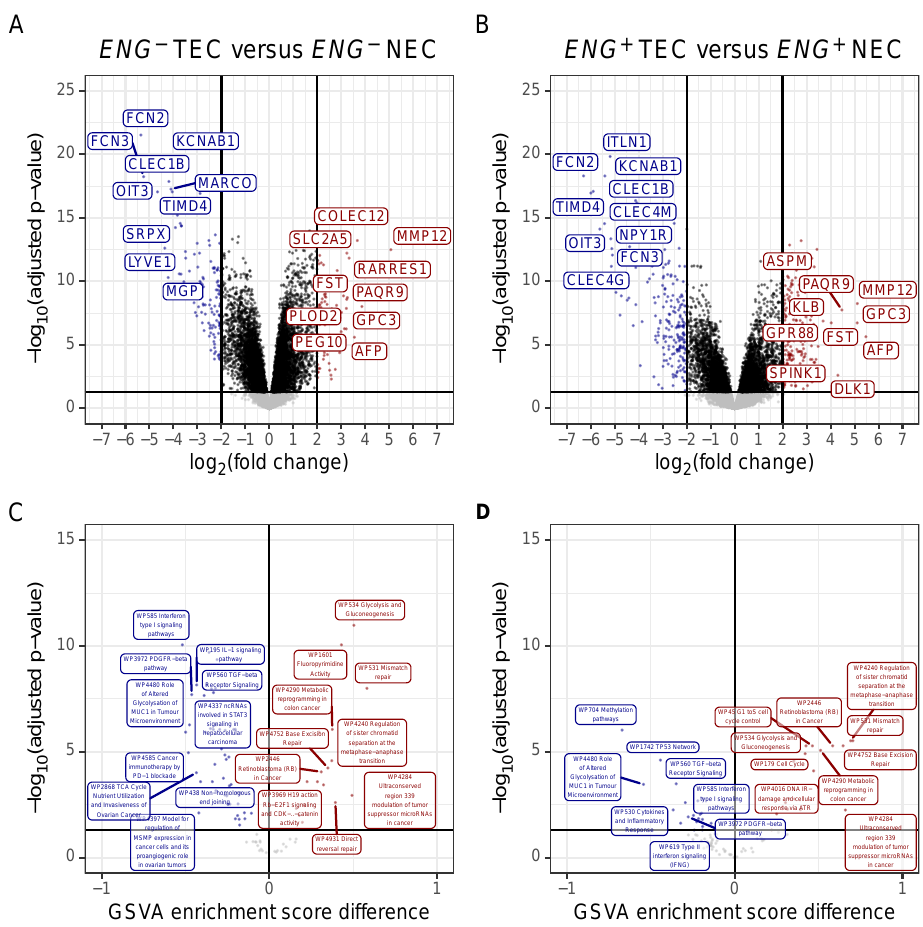
Figure 4. Differential gene expression and pathway perturbation in ENG − and ENG + TEC. ( A ) Dif- ferentially expressed genes in ENG − TEC and ( B ) in ENG + TEC. ( C ) Perturbed Wikipathways in ENG − TEC and ( D ) in ENG + TEC. Negative GSVA score difference (blue) indicates down-, positive GSVA score difference (red) indicates upregulation of the respective pathway in TEC. Horizontal lines indicate an FDR of 0.05. The top ten up and down-regulated genes (in term of log2FC) and pathways (in terms of GSVA score difference) are labelled. The controls for ENG − TEC and ENG + TEC were ENG − NEC and ENG + NEC,